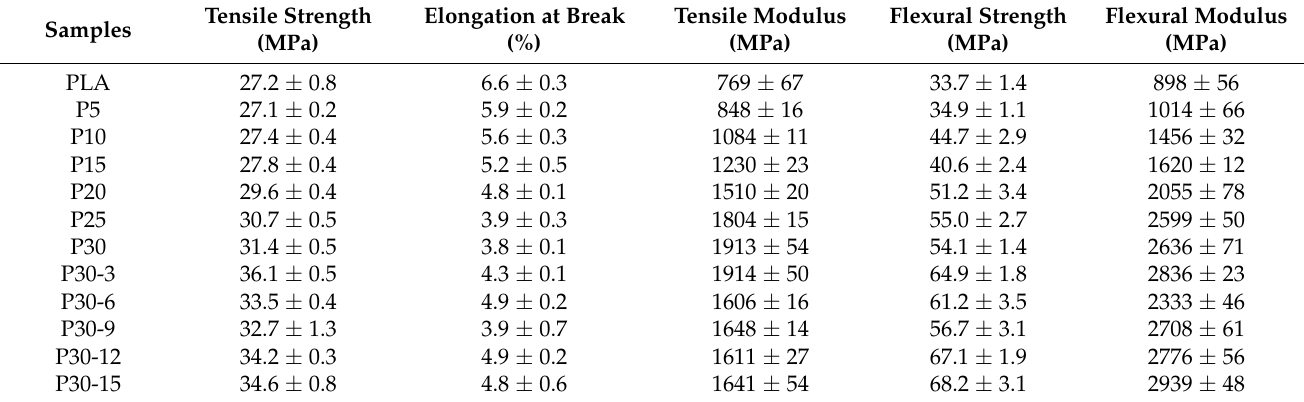
Table 2. Mechanical properties of WCPF/PLA composites prepared in different